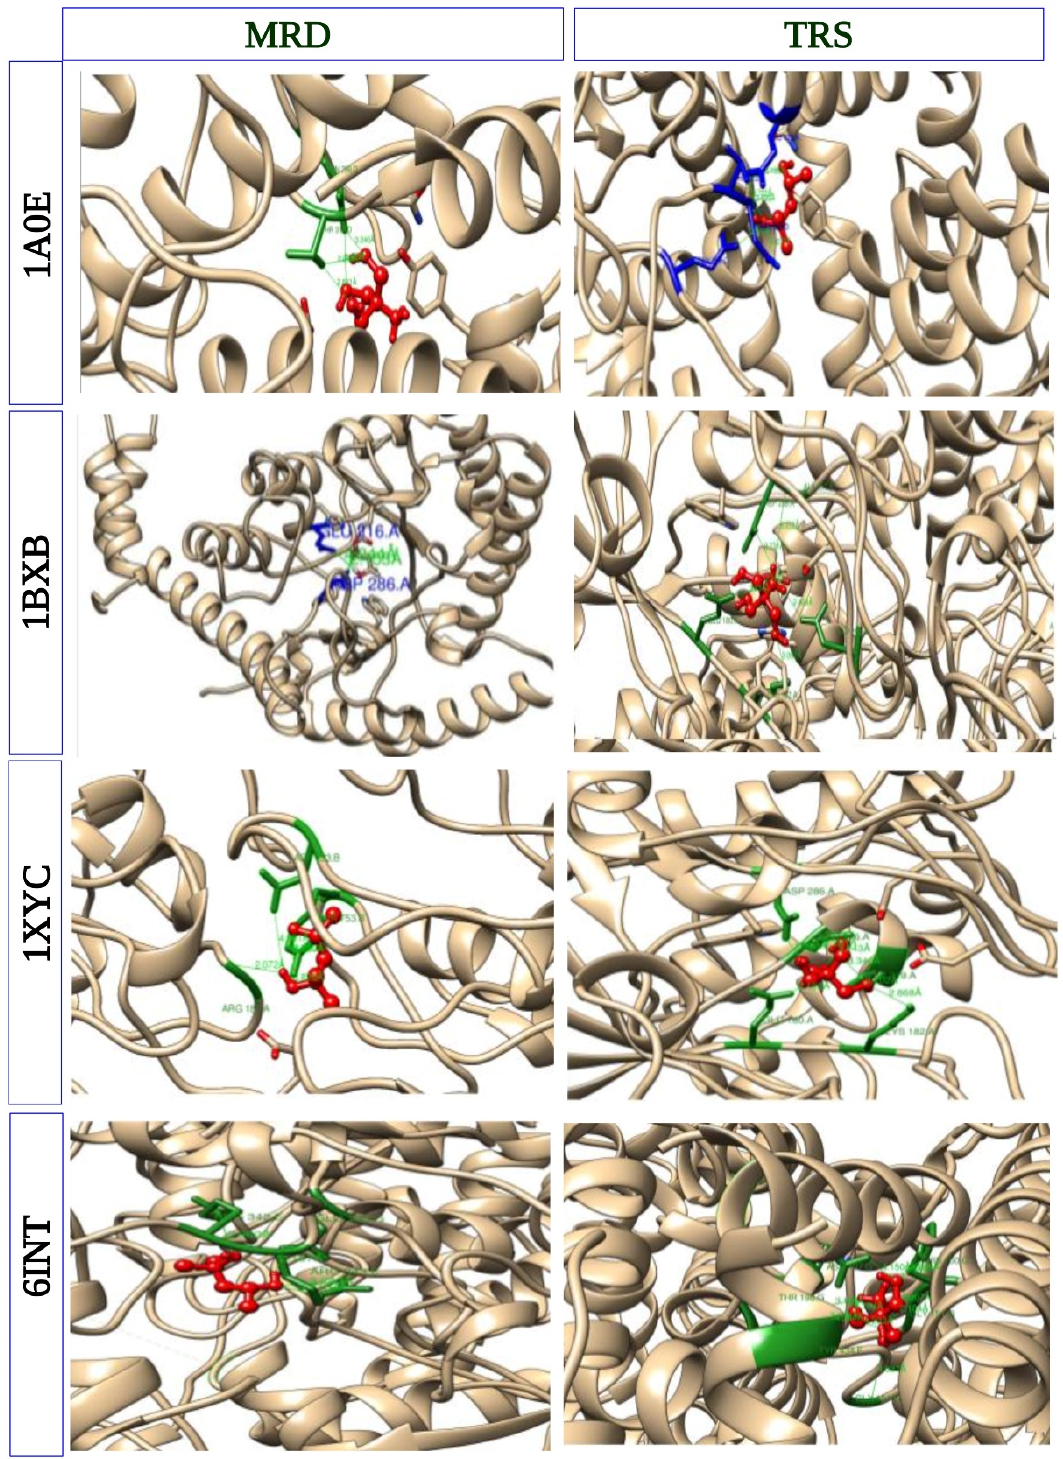
Figure 3. Molecular docking analysis of xylose isomerase enzymes from four different classes, i.e., hyperthermophile (1A0E), thermophile (1BXB), mesophile (1XYC), psychrophile (6INT) against two different small molecules [(4R) ‐ 2 ‐ Methylpentane ‐ 2,4 ‐ Diol and Amino ‐ 2 ‐ Hydroxymethyl ‐ Propane ‐ 1,3 ‐ Diol].